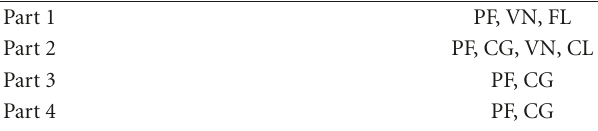
Table 5: Number of notes in mixed-sound templates (Type I). Tem- plates of Types II and III have about 1/2 and 1/3–1/4 times the notes of Type I (details are omitted due to a lack of space). S + D and S + D + T stand for the templates constructed from audio signals of solo and duo music, and from those of solo, duo, and trio music, respectively.